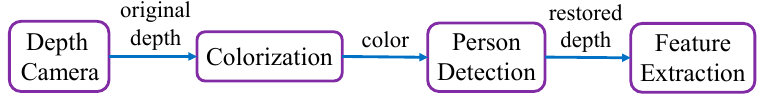
Figure 3. Alternating pixel values between depth and color values.